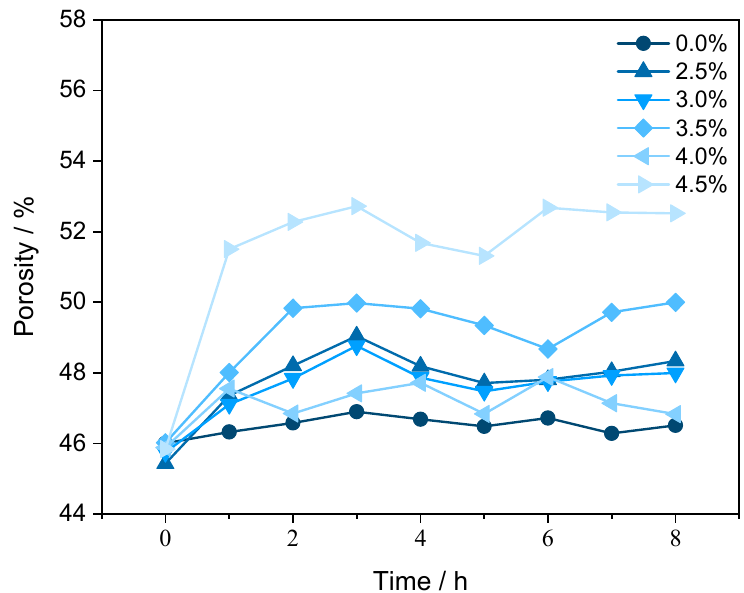
Figure 6. Porosity changing curve of samples with different concentrations of leaching agents in the leaching process.